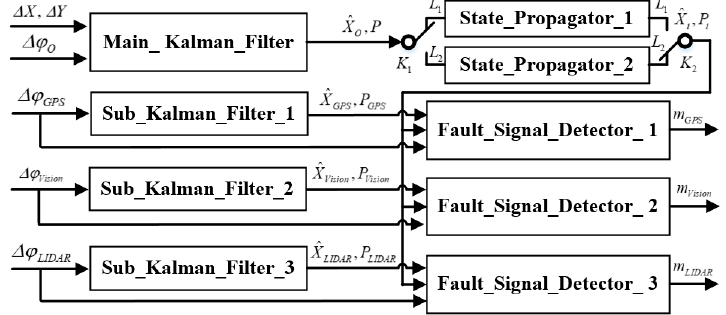
Figure 3. The block diagram of proposed faults signals detector.